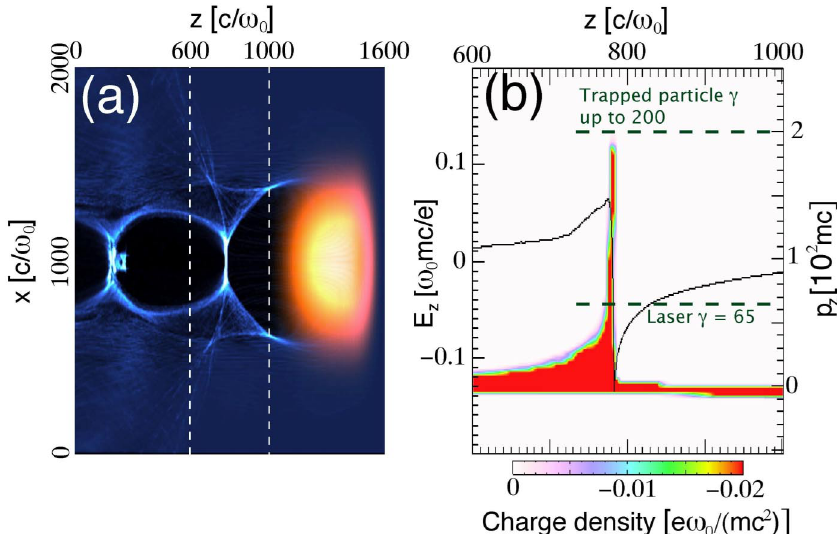
FIG. 6. (Color) Panel (a) shows the laser electric field with orange on top of the electron density with blue after 0.4 mm of propagation. The laser front is chosen sharper than the back because it has been found through simulations that this leads to more stable propagation. The blowout region is well formed. Panel (b) shows that particles at the rear of the ion channel have already reached velocities higher than the laser velocity and therefore are trapped. The region in the z direction plotted in panel (b) corresponds to the z region between the broken lines in panel